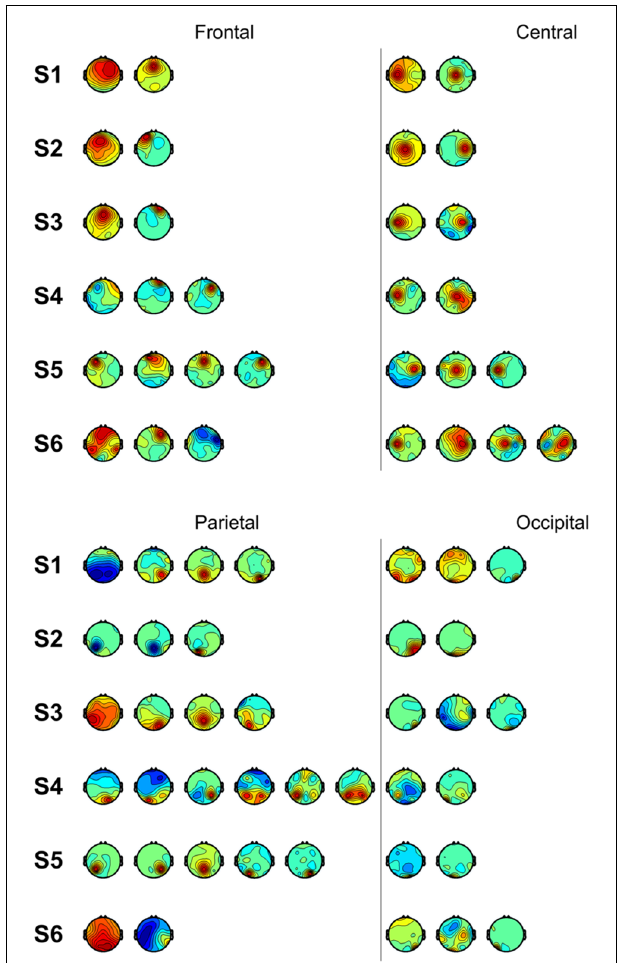
FIGURE 3 | Scalp maps of independent components categorized according to area of peak activity for all subjects.